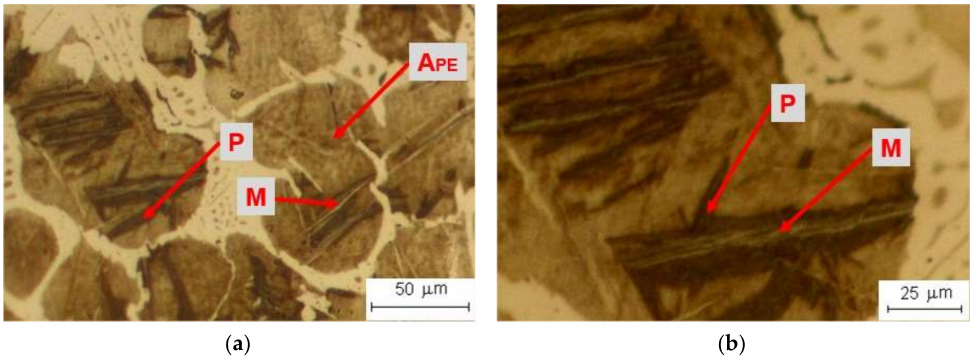
Figure 8. Klemm reagent: ( a ): general view at 200 × ; ( b ) detail at 500 × .